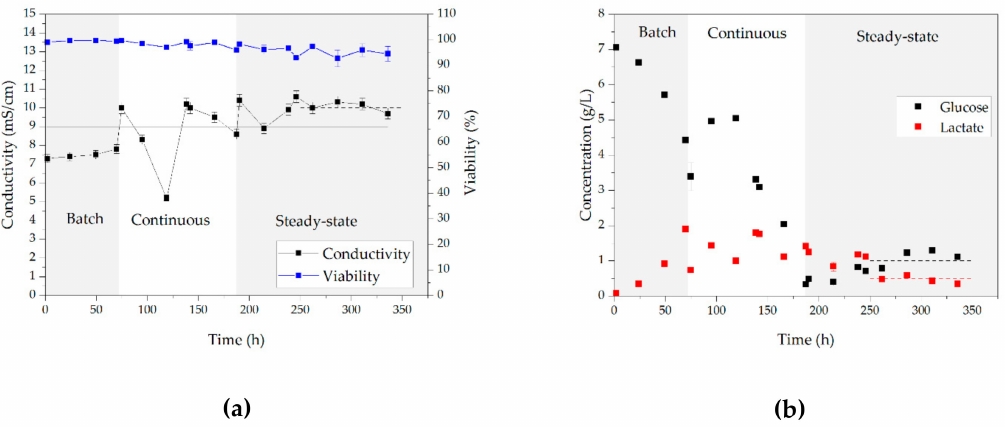
Figure 9. Conductivity, cell viability ( a ), and glucose and lactate concentration ( b ) during batch, continuous, and continuous steady-state cultivation. The horizontal solid line depicts the mean conductivity of 9.0 ± 1.4 mS / cm. The horizontal dashed line visualizes schematically the subsequent course of the steady-state phase after its initiation at 187 h. Error bars depict the double determination of conductivity, viability, glucose and lactate